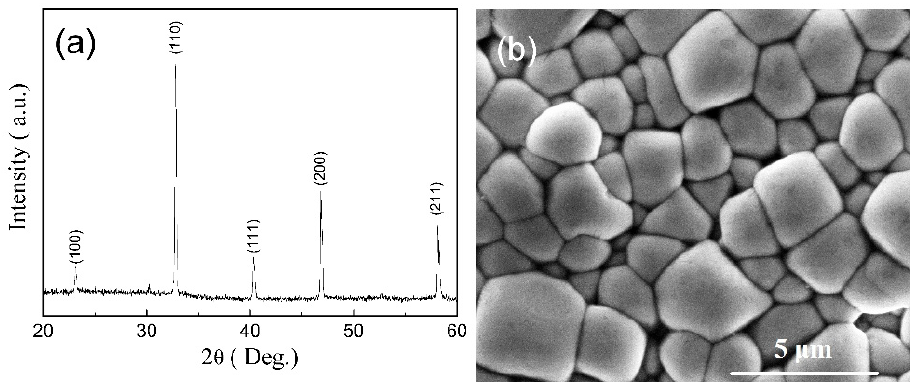
Figure 4. XRD pattern ( a ) and SEM surface image ( b ) of the BNT-BT thick film.